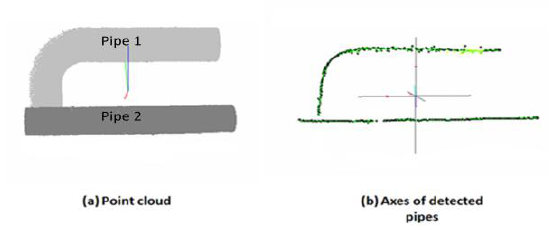
Figure 9. Elbow and straight pipe detection with point spacing of 0.02m, a) shows the detected segments and b) shows the ellipse centres detected in the profile.